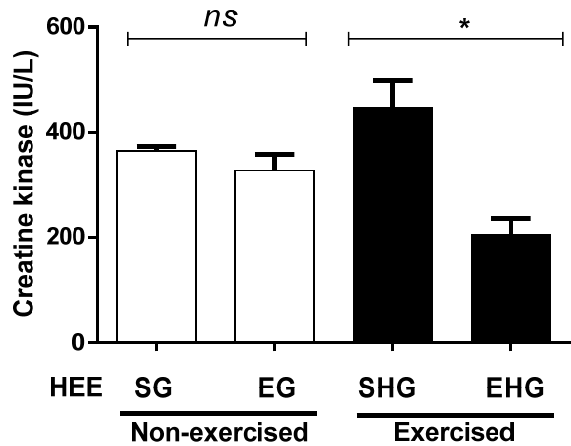
Figure 5. Plasma concentration of creatine kinase in animals exercised and subjected to the administration of hydroethanolic extract of C. argyrophyllus (HEE). The results are presented as mean ± SEM and evaluated by one ‐ way ANOVA with a Bonferroni post test; p < 0.05. ns: not significant; * differences between the exercised groups. SG—sedentary vehicle group; EG—exercise vehicle group; SHG—sedentary group HEE; EHG—HEE exercise group.